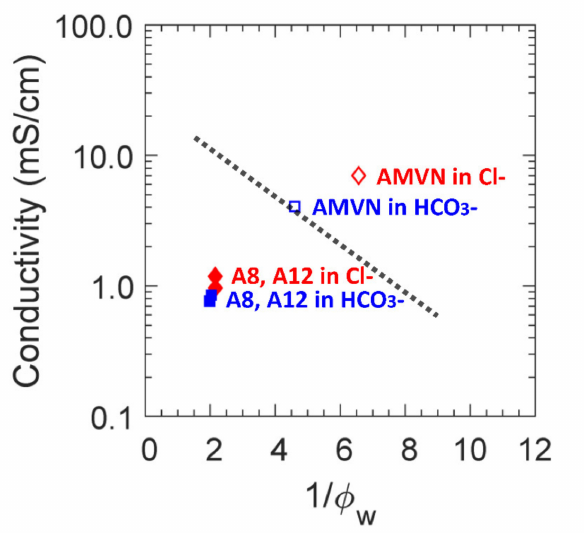
Figure 4. Ionic conductivity as a function of inverse water volume fraction for A8, A12 (filled markers) and AMVN (empty markers) in Cl − (diamonds, ♦ ) and in HCO 3 − (squares, (cid:3) ). The line is a regression on a series of ImPPO- χ AEMs and Selemion ® AMV from the literature